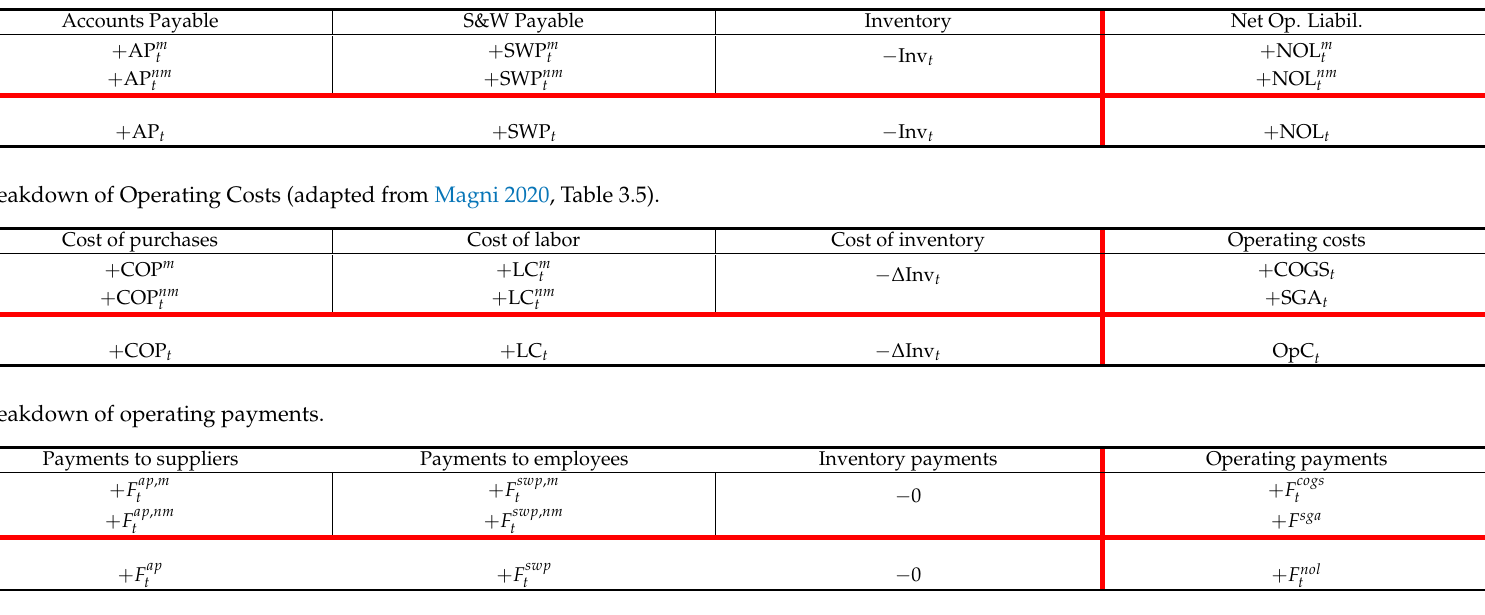
Table 1. Breakdown of Net Operating Liabilities (adapted from Magni 2020, Table 3.6).